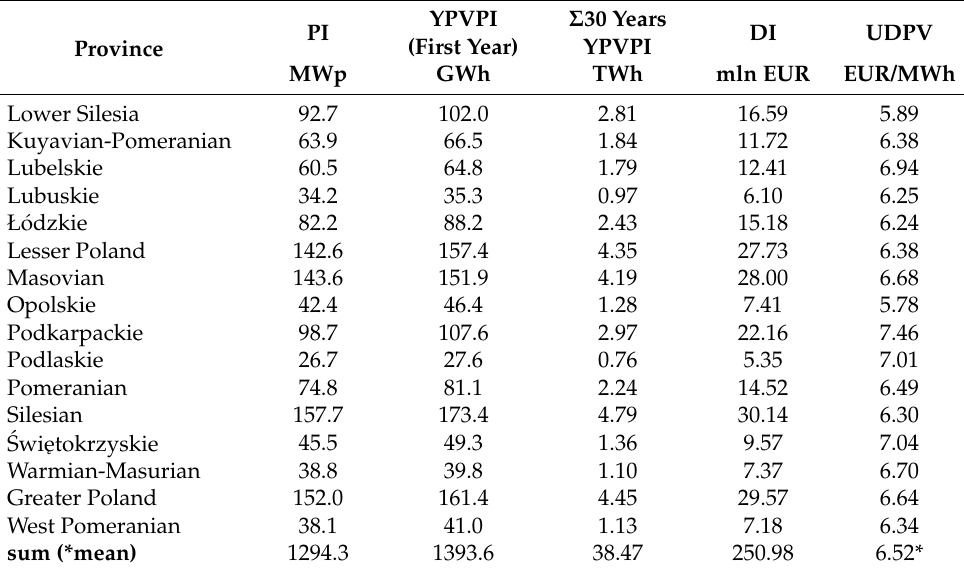
Table 2. Globally electricity production and dotation per MWh per province.